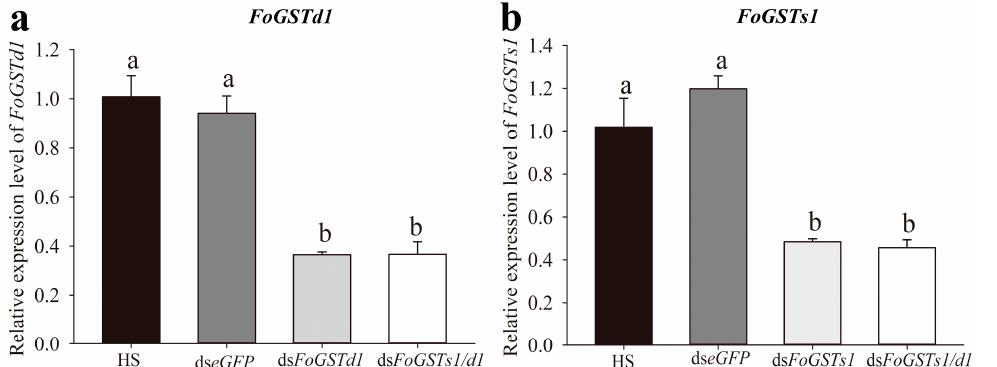
Figure 7. Downregulation of FoGSTd1 and FoGSTs1 expression levels in second-instar larvae of Frankliniella occidentalis when fed dsRNA solutions. ( a ) Relative expression level of FoGSTd1 ; ( b ) Relative expression level of FoGSTs1 . Values are the mean ± SE. Different lowercase letters indicate significant silencing among all treatments ( p < 0.05; one-way ANOVA, followed by Tukey’s test).